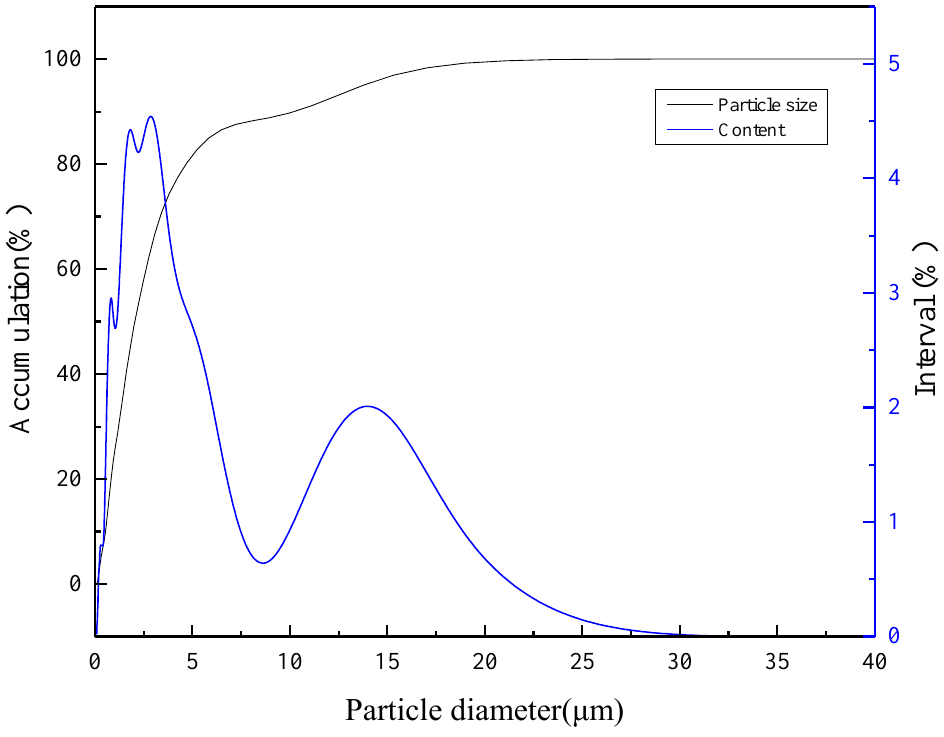
Figure 2. Particle size analysis of wolframite single mineral.